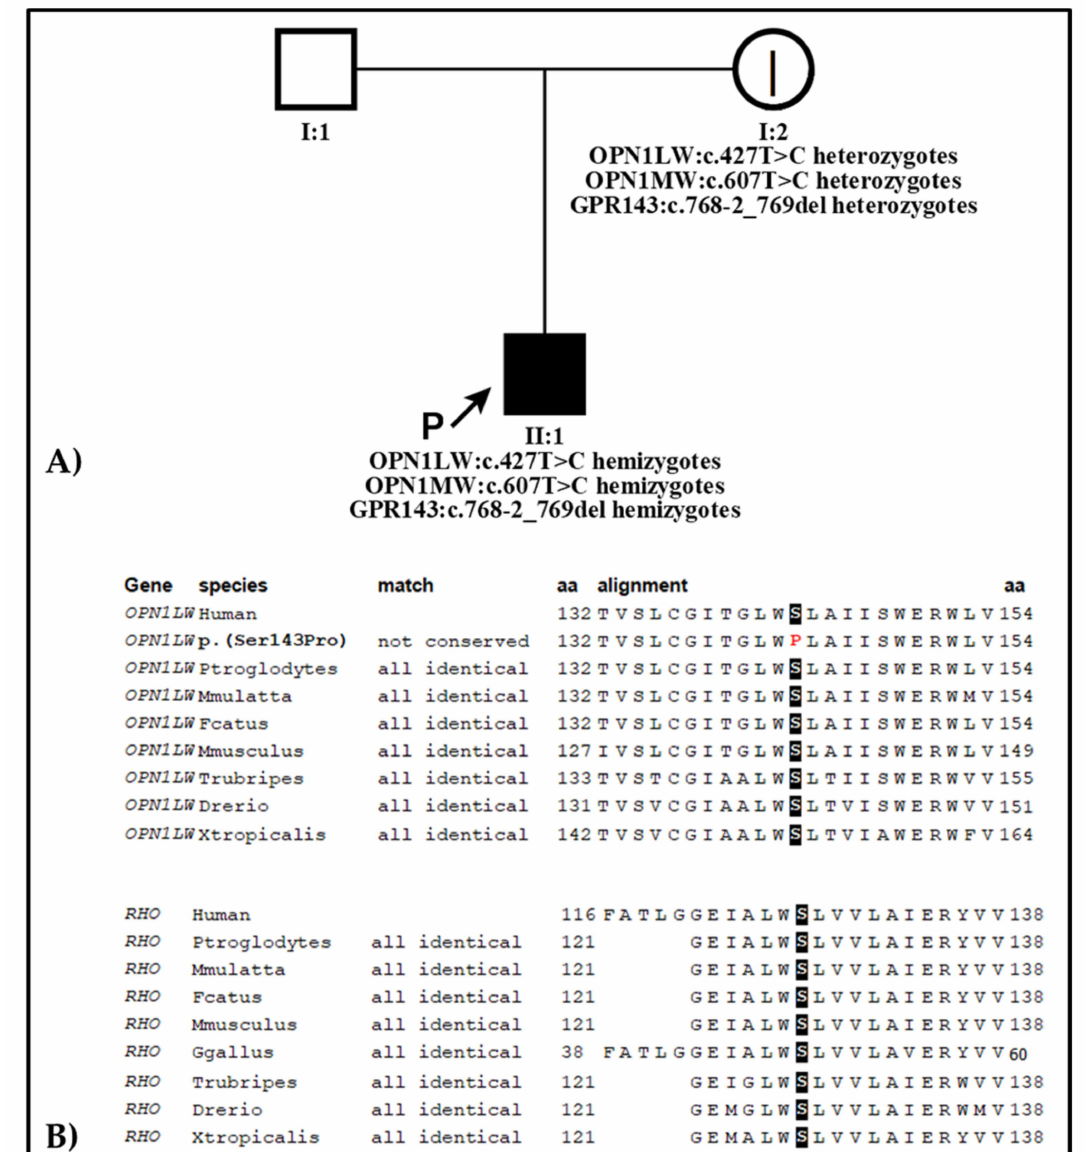
Figure 7. ( A ) Family tree showing the X-linked recessive transmission of the two diseases. Legend: P, proband; |, subclinic phenotype; ( B ) Amino acid (aa) conservation across species of the novel OPN1LW variant showing that long-wave-sensitive opsin-1 Ser143 is highly conserved. Ser143 in the OPN1LW gene corresponds to Ser127 in the human rhodopsin gene RHO ; the alignment shows that the amino acid serine is conserved across species also in RHO; this variant was not found in any queried database and was classified as likely pathogenic by VarSome, thus further supporting the evolutionary and functional importance of the